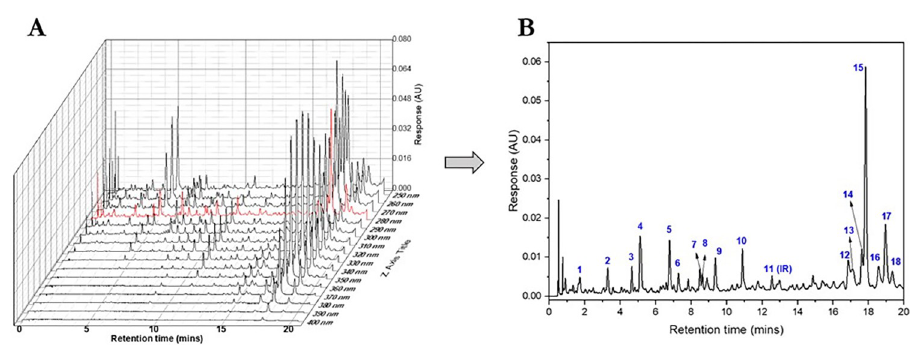
Fig 2. Representative UPLC fingerprint profile for ESB extract. [A]–Stack illustration of chromatograms of the extract at different wavelengths. The red highlighted chromatogram (that is, at 280 nm) was selected for the fingerprinting analysis. [B]–The fingerprint detected at 280 nm showing 20 prominent peaks used to identify the extract. The peak 11, which was identified to be vicenin-2 was selected as the internal reference (IR) peak.